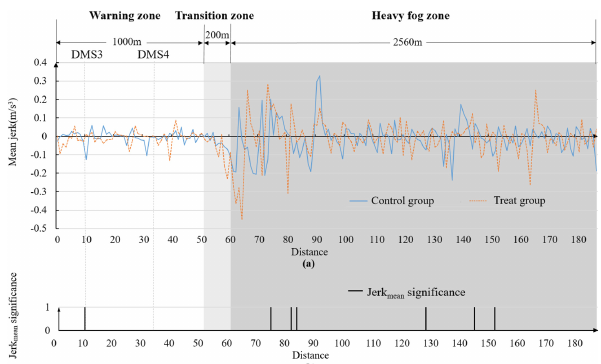
Figure 8 Effect of the fog warning system on